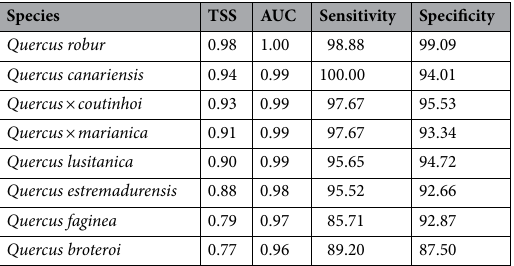
Table 1. Evaluation scores per species for the ensemble of 21 top-models (TSS: True skill statistic; AUC: Area Under the Curve; Sensitivity also called true positive rate or recall; Specificity also defined as the true negative